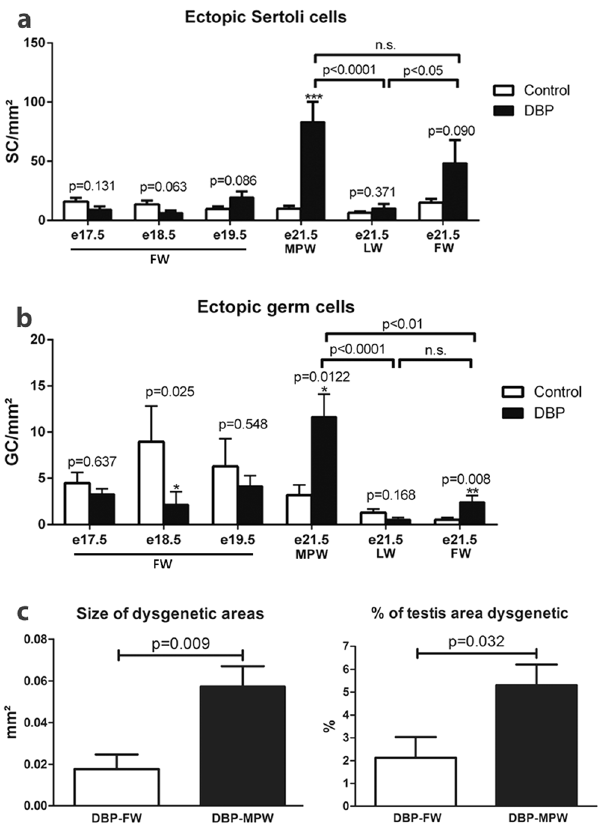
Figure 5. DBP-induction of testicular dysgenesis in relation to the time-window of DBP exposure. Dysgenesis was measured by the number of ectopic Sertoli (SC; a ) and germ cells (GC; b ) per mm² testis cross-section between e17.5 and e21.5, or at e21.5 ( c ) as the average size of dysgenetic areas per testis cross-section or as the % of testis cross-sectional area that was dysgenetic. Note that whichever measure of dysgenesis is used,